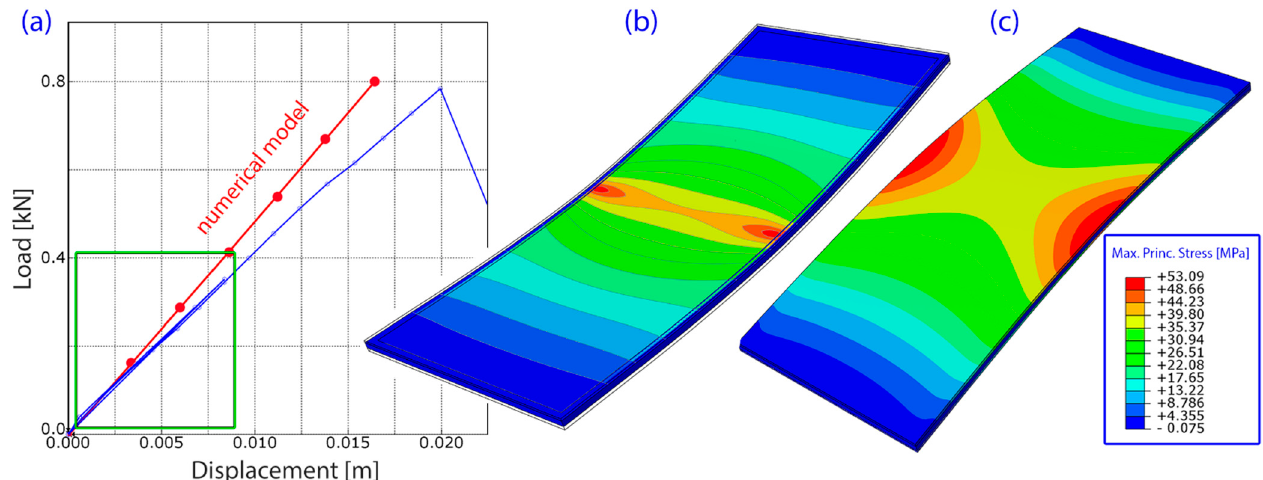
Figure 17. Rectangular model validation test: ( a ) equilibrium path (load-displacement); ( b ) contour plots showing the maximum principal stress in the top panes; ( c ) maximum principal stress in the bottom panes.